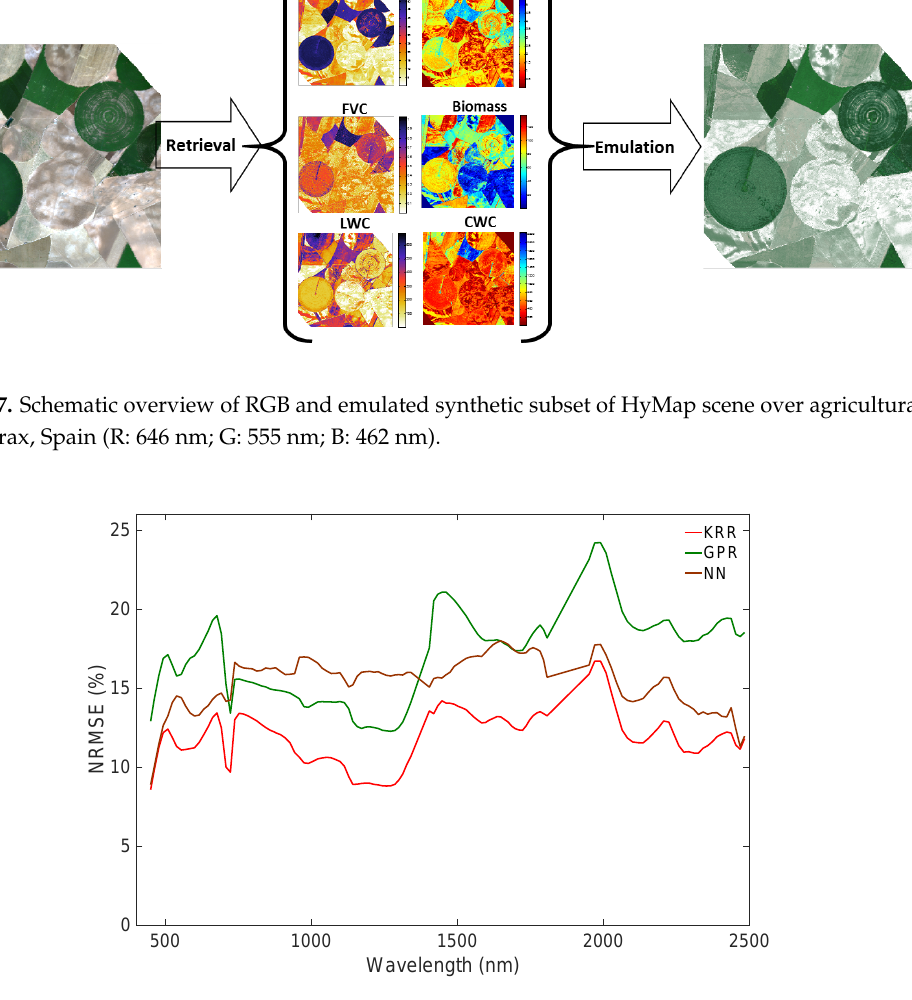
Figure 8. Wavelength-dependent NRMSE (%) comparison of scenes as generated by the three tested emulators (KRR, GPR, and NN) against a reference HyMap